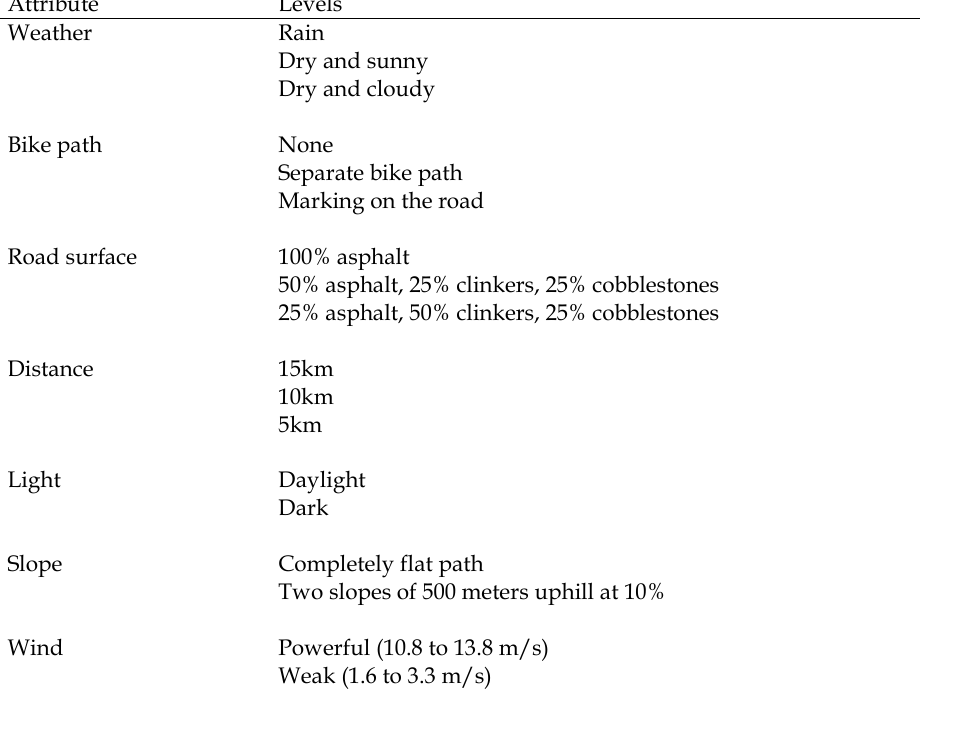
Trajectory attributes and their levels in the survey